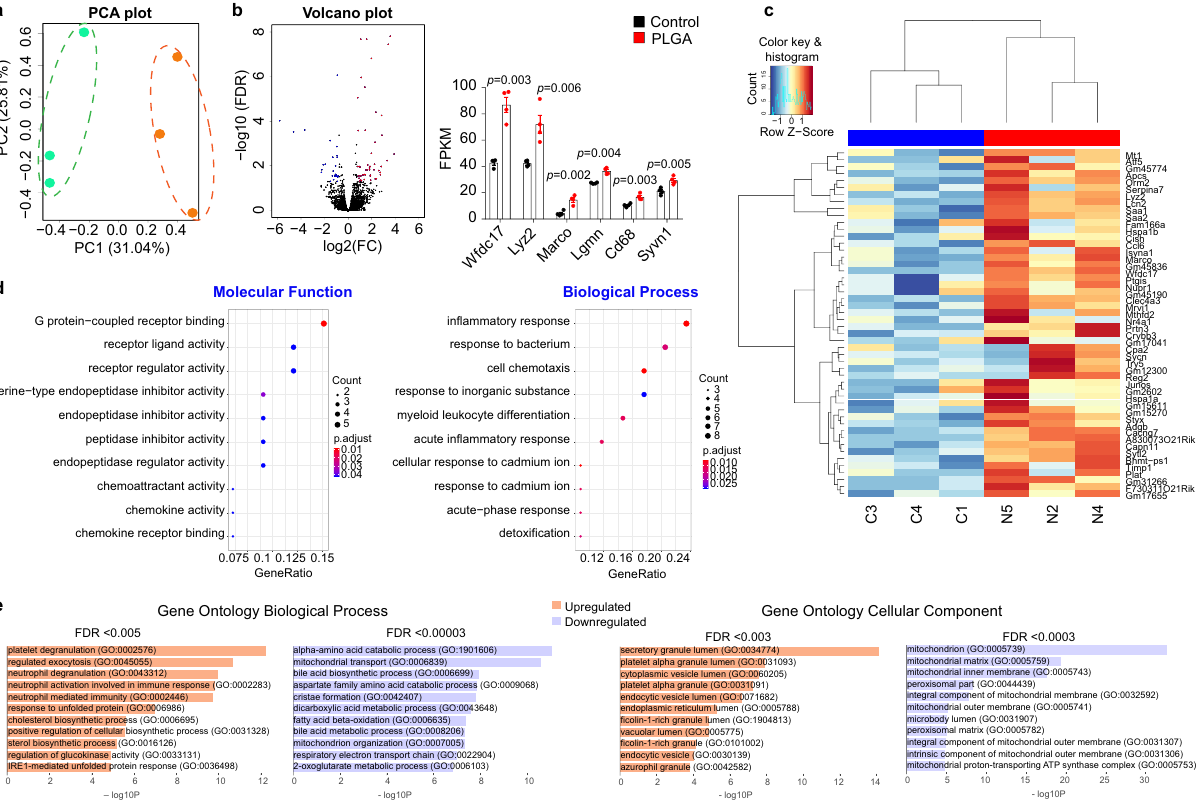
Figure 4. RNA-seq transcriptome analysis identifies metabolism, enzymatic degradation and cellular stress pathways in liver. ( a ) Principal component analysis (PCA) of whole-transcriptome RNA-seq read counts in liver. Dotted ellipses indicate the 95% confidence interval of samples that fall into two distinct groups (PLGA nanoparticle-treated and control). Axis percentages indicate variance in the data contribution (n = 3/ group); ( b ) Volcano plot indicating the genes in liver with significantly increased (red dots) or decreased (blue dots) expression in PLGA treated group compared to control. The x-axis shows log2 fold-changes (FC) in the expression and the y-axis the log 10 false discovery rate (FDR) of a given gene being differentially expressed. Selected most significantly regulated genes are plotted in the bar graph as gene vs. fragments per kilobase of transcript per million mapped reads (FPKM): Wfdc17: activated macrophage/microglia WAP domain protein ( t-value : − 7.225; degrees of confidence : 3.414); Lyz2: lysozyme C-2 ( t-value : − 4.166; degrees of confidence : 6); Marco: macrophage receptor with collagenous structure ( t-value : − 5.416; degrees of confidence : 6); Lgmn: legumain ( t-value : − 7.369; degrees of confidence : 3.283); CD68: cluster of differentiation 68 ( t-value : − 4.777; degrees of confidence : 6); Syvn1: Synoviolin 1 ( t-value : − 4.286; degrees of confidence : 6); (n = 4 mice/group, independent t -test, p < 0.05); ( c ) Heatmap of hierarchical clustering indicates differentially expressed genes (columns) in liver from individual control (C3, C4, C1) and PLGA nanoparticle-treated animals (N5, N2, N4) samples (n = 3/group); ( d ) Gene ontology (GO) analysis presented as a scattergram of overrepresented GO terms in molecular function and biological process categories; ( e ) Additional GO analysis using more stringent FDR filtering (as indicated above the plot) demonstrated upregulation of various cell exocytosis and secretion pathways and downregulation of oxidative metabolism (mitochondrial function) pathways in